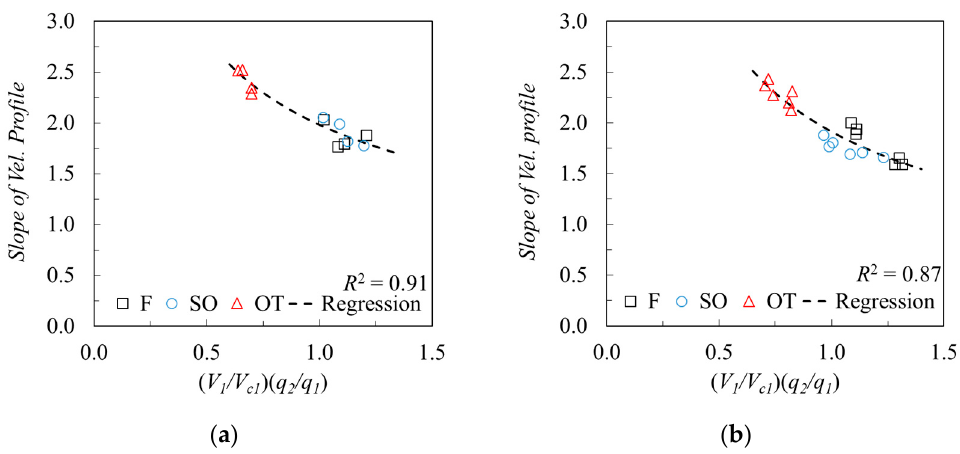
Figure 7. Variation of velocity gradient close to the bed as a function of (cid:4666)𝑉 (cid:2869) 𝑉 (cid:3004)(cid:2869) ⁄ (cid:4667)(cid:4666)𝑞 (cid:2870) 𝑞 (cid:2869) ⁄ (cid:4667) for ( a ) in